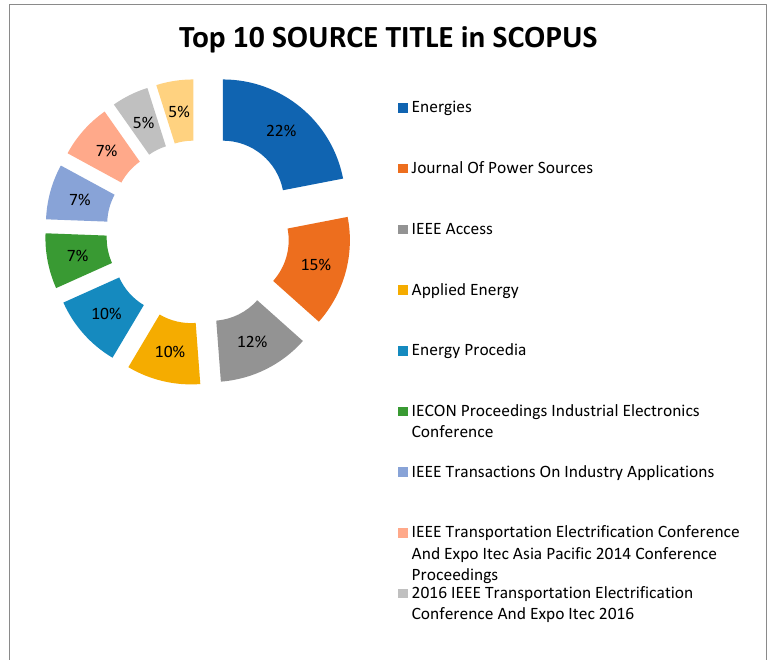
World Electr. Veh. J. 2022 , 13 , x FOR PEER REVIEW Figure 12. Top five cited papers of BMS EV across 5 years in SCOPUS DB. Figure 13. Top five cited papers of BMS EV across the last 5 years in WOS DB.